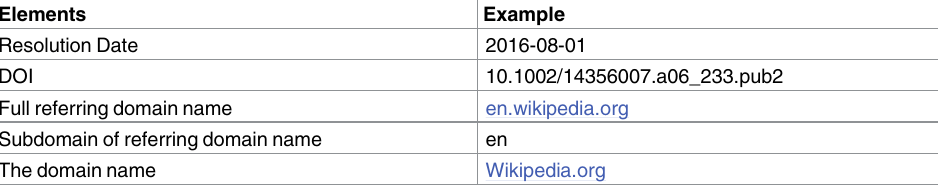
Table 1. Example of data elements provided by Crossreffor each DOI resolved in August 2016.